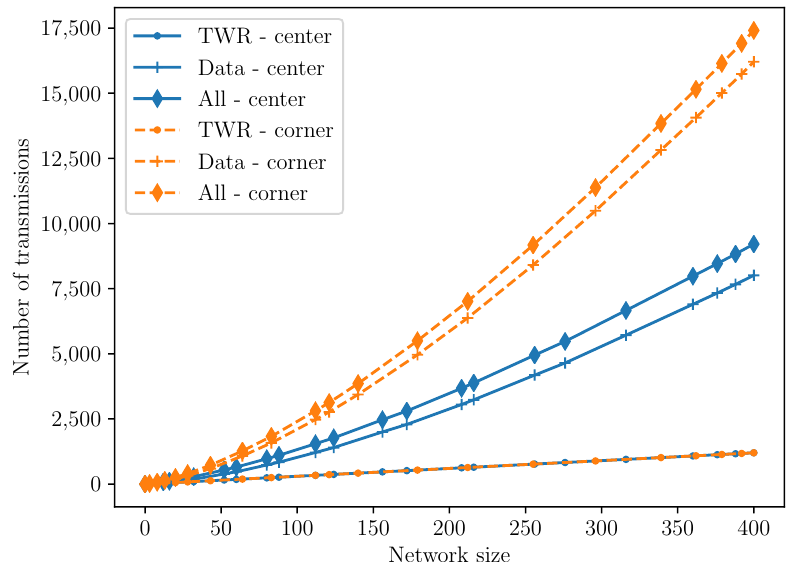
Figure 19. Number of transmissions as a function of the network size. The differences in network sizes between the two sink placements can be attributed to the expansion process explained in Section 6.2.